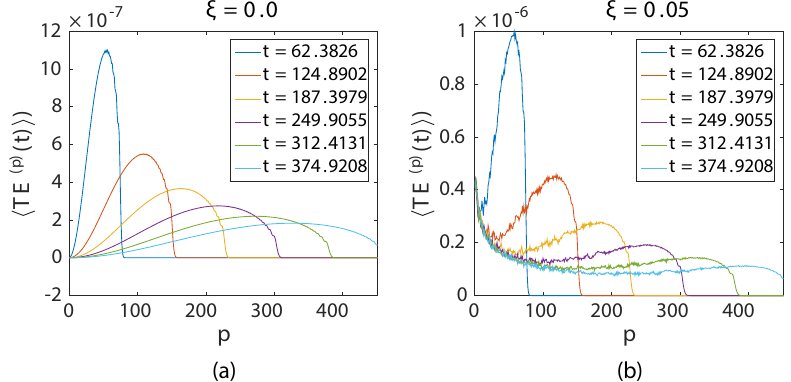
Figure 2. Ensembled total energy signal at different instances of time for ( a ) ordered and ( b ) disordered chains.